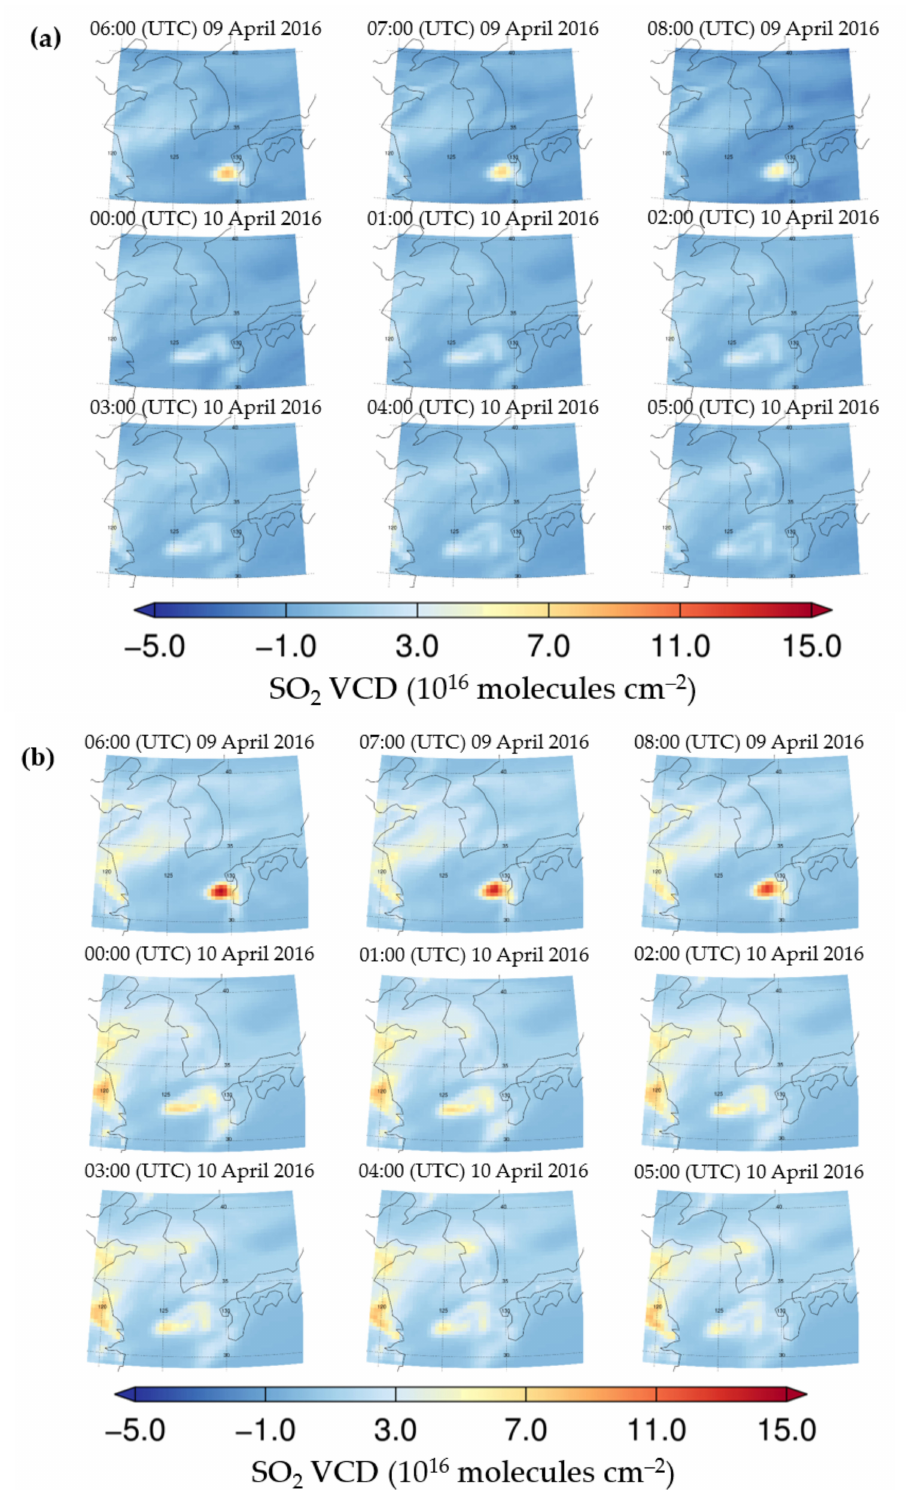
Figure 9. Examples of SO 2 VCDs retrieved from ( a ) GEMS synthetic radiances and ( b ) true SO 2 VCDs for 9–10 April